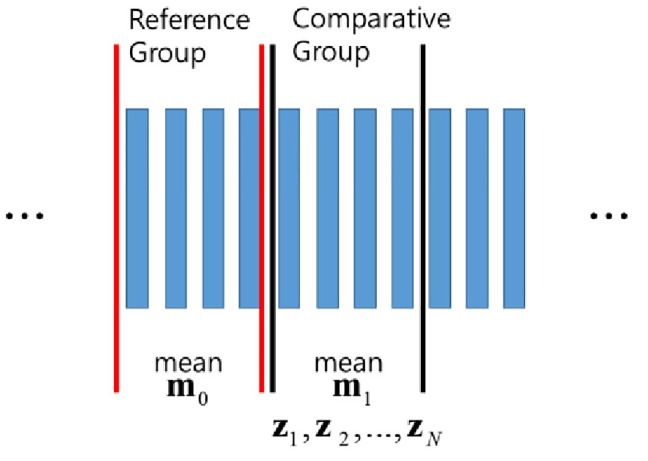
Fig 2. “Sliding window”